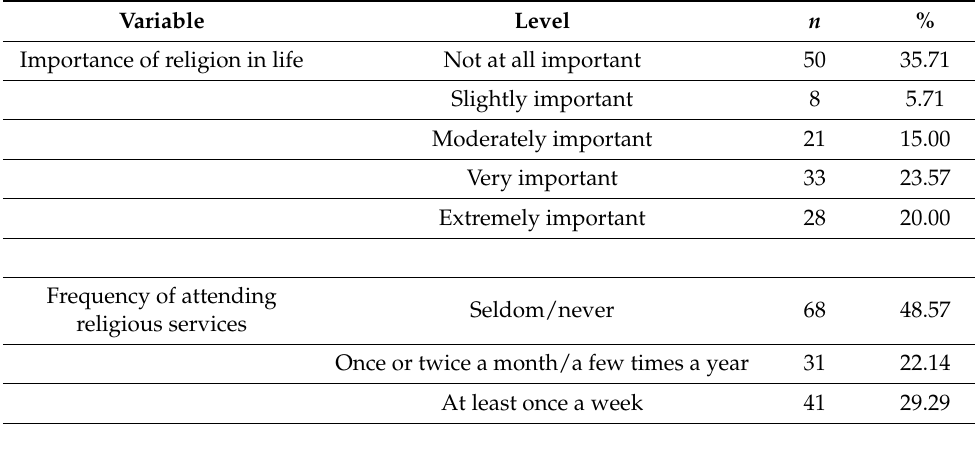
Table 2. Participants’ religiosity, political ideology, and party